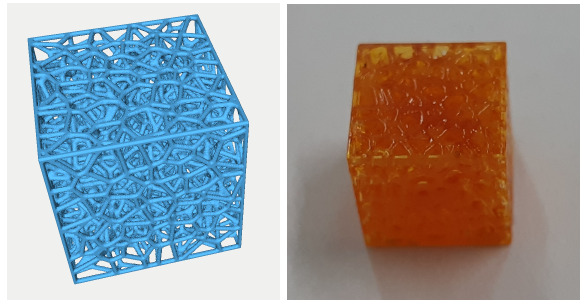
Figure 4. The numerical model of porous structure prepared for the addictive manufacturing (left). The printed model using DLP technology. The size of the printed cube is 10 × 10 × 10 mm